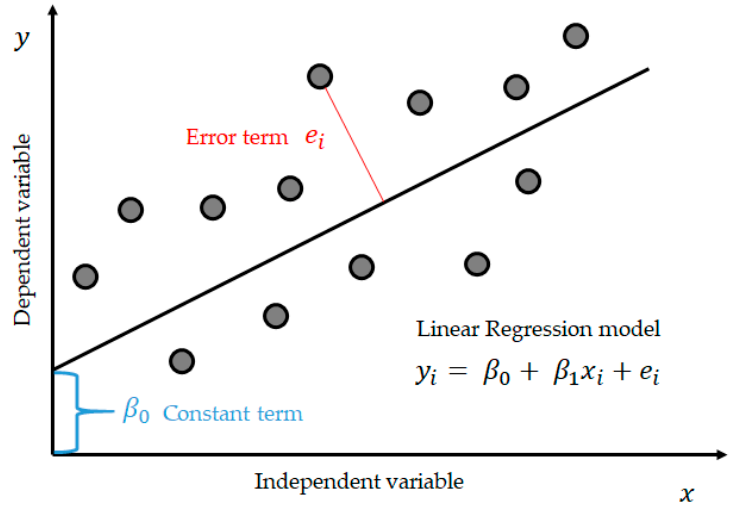
Figure 6. Concept of linear regression (LR) model.